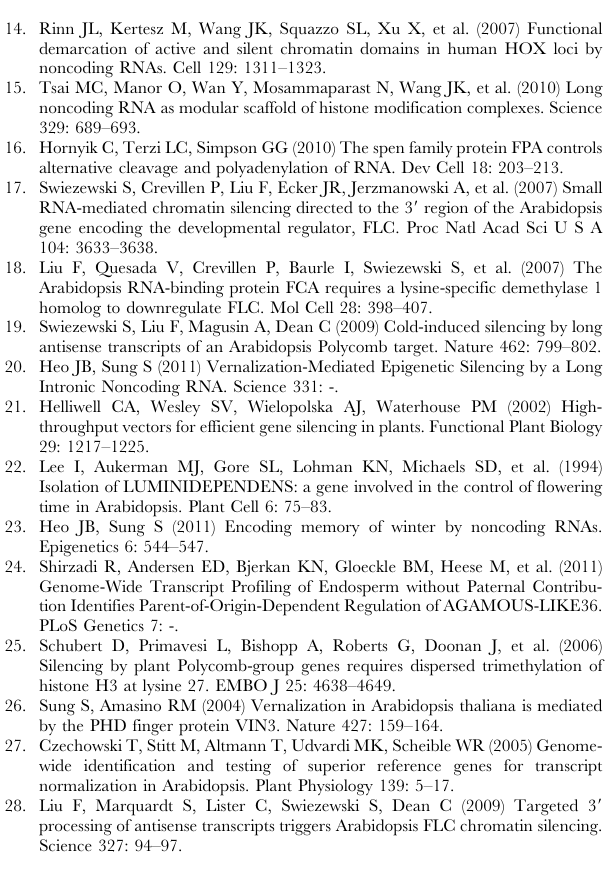
Figure S1 H3K27me3 ChIP qPCR across FLC in C24 and flc-20 . ChIP qPCR for amplicons 1–12 [11] in C24 and flc-20 plants grown for 12 long days (12LD), 12 long days followed by 4 weeks at 4 u C (12 + 4V) or 12 long days, 4 weeks at 4 u C followed by 2 long days (12LD + 4V + 2LD). (TIF) Figure S2 H3K27me3 ChIP qPCR across FLC in Col FRI , SALK_092716, SALK_140021 and SALK_131491. ChIP qPCR for amplicons 1–12 (Buzas et al , 2011) in Col FRI , SALK_092716, SALK_140021 and SALK_131491 plants grown for 12 long days (12LD), 12 long days followed by 4 weeks at 4 u C (12 + 4V), 12 long days, 4 weeks at 4 u C followed by 2 long days (12LD + 4V + 2LD) or 12 long days, 4 weeks at 4 u C followed by 5 long days (12LD + 4V + 5LD). (TIF) Table S1 Oligonucleotide sequences.